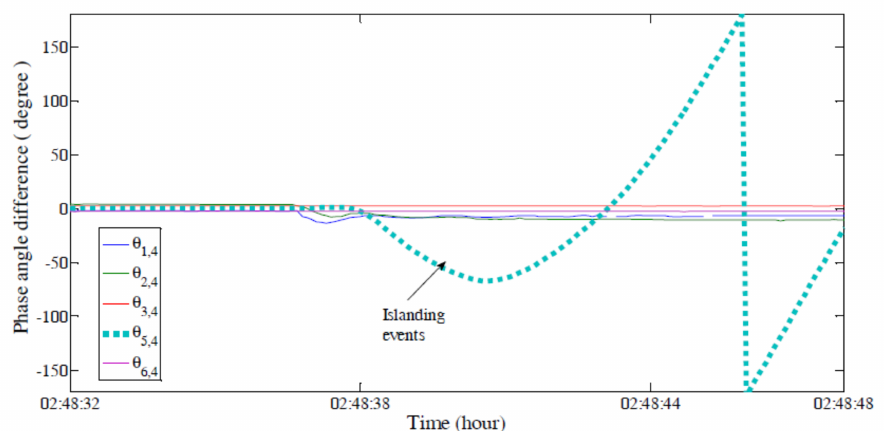
Figure 12. PMU phase angle used for detecting islanding events [34].